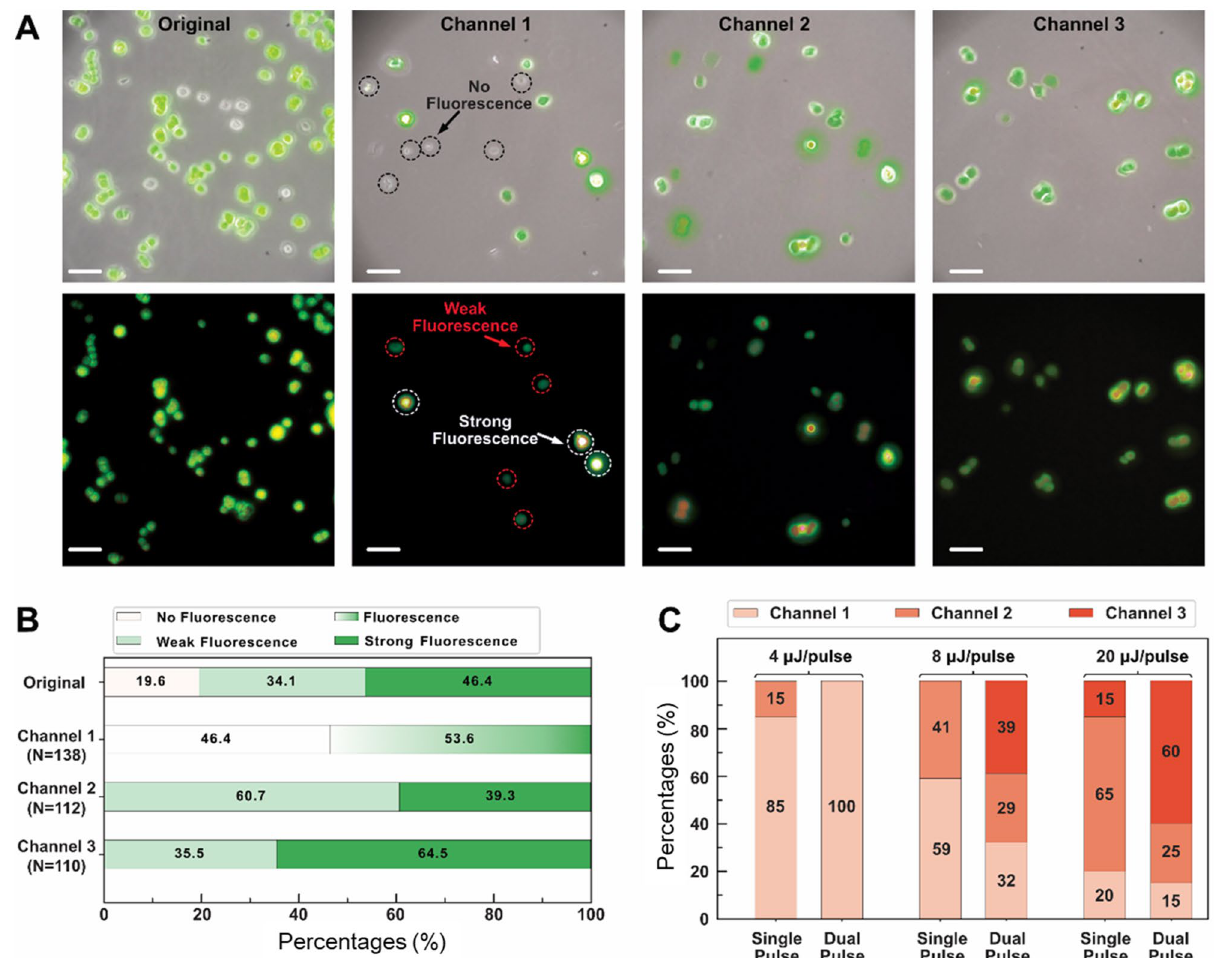
Figure 6. Demonstration for sorting PC-12 cells with varying fluorescence intensities. ( A ) Images of the original mix and the sample as the outputs of Channels 1 to 3. ( B ) Pre- and post-sorting changes in the percentages of nonfluorescent cells, weakly fluorescent cells, and strongly fluorescent cells. The pulse energy for the sorting was 8 μJ/pulse. ( C ) Effect of femtosecond pulse energy on the lateral displacement of PC-12 cells (n = 20 for each condition). The scale bars represent 40